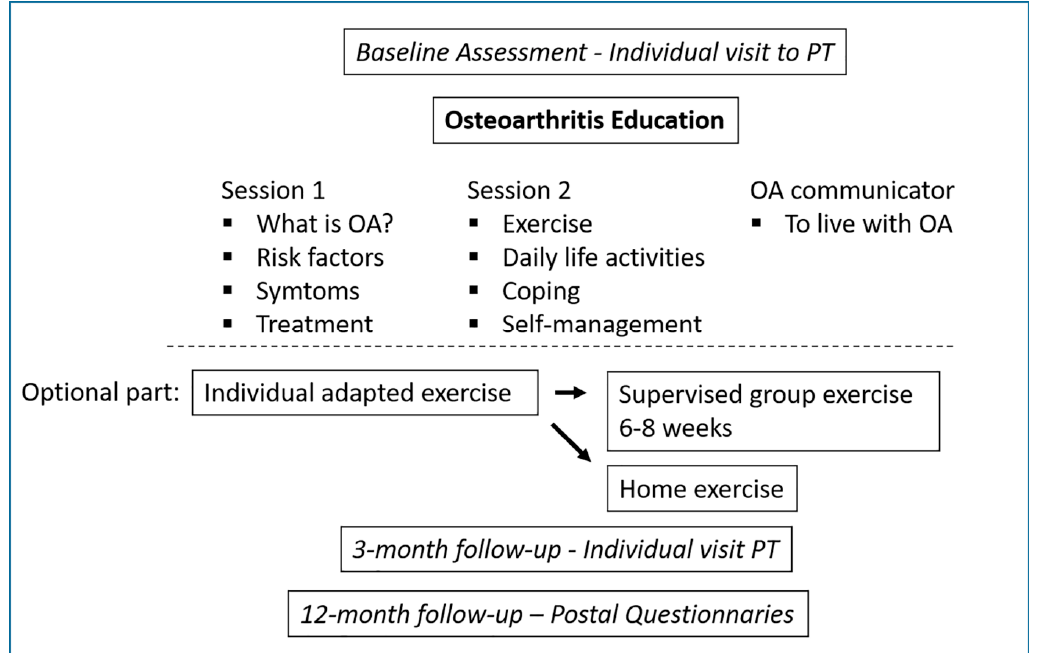
Figure 1. Overview over the education and exercise parts of the BOA self-management program. PT = Physiotherapist. Retrieved with copyright permission from: Jönsson T., Eek F., Dell’Isola A., et al.